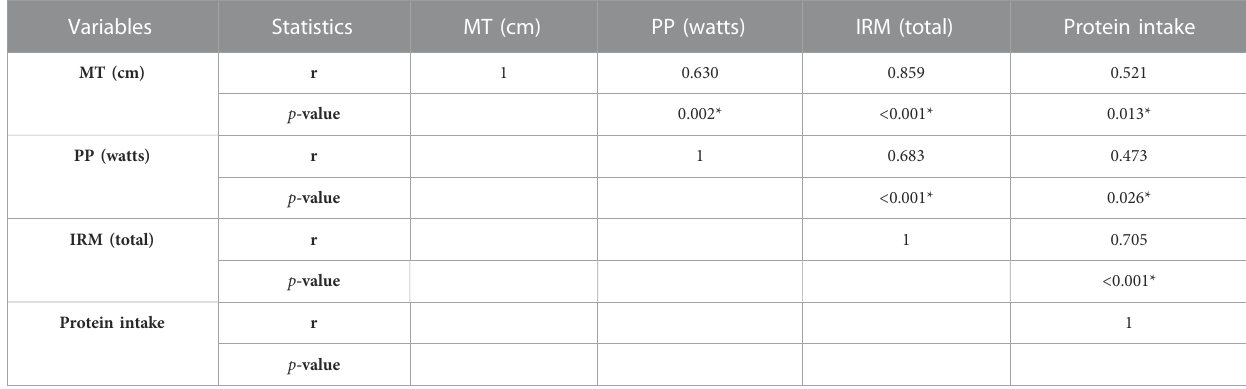
TABLE 6 Correlation analysis results between protein, fat free, MT and PP.